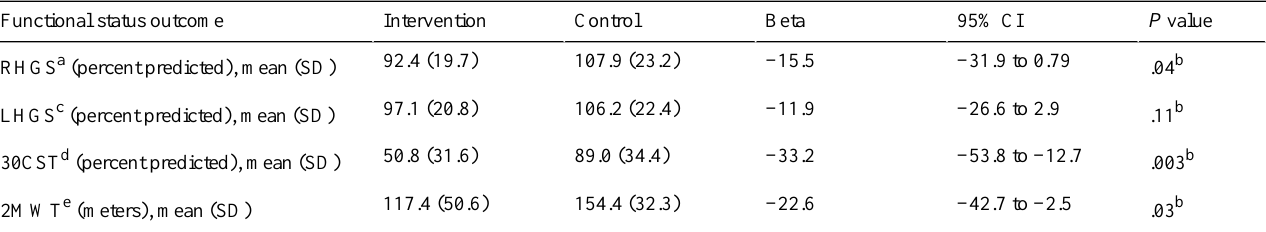
Table 3. Functional status capacity outcome measures at hospital discharge (T0). Beta values represent the differences in functional status between the historical control group and the intervention group at T0.